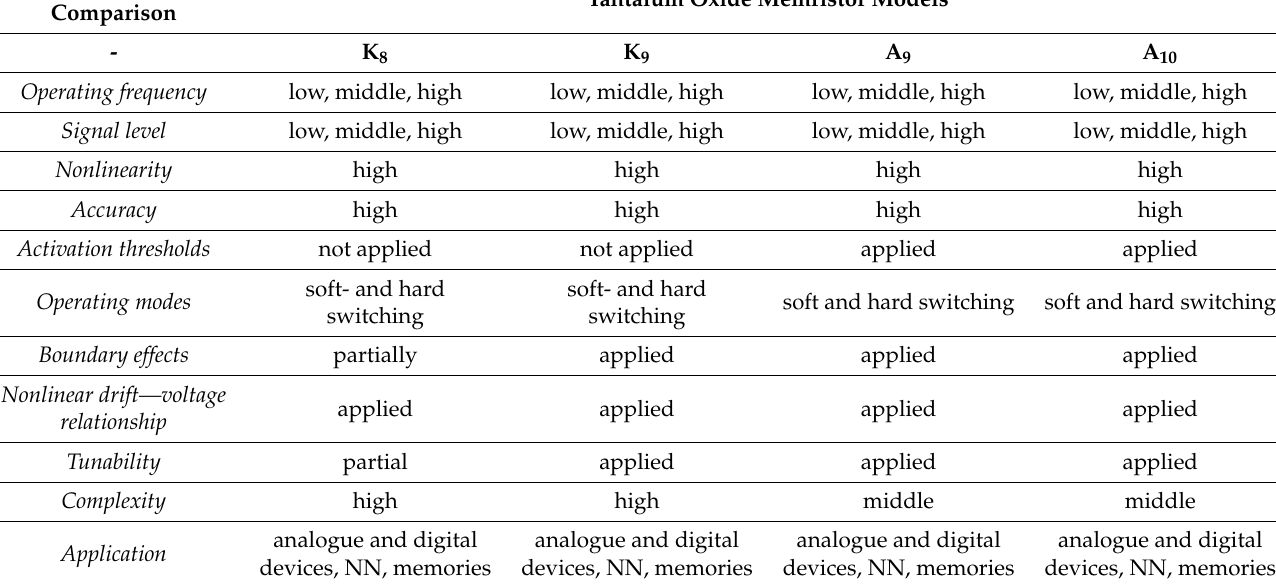
Table 3. Comparison of the considered existing and modified Ta 2 O 5 memristor